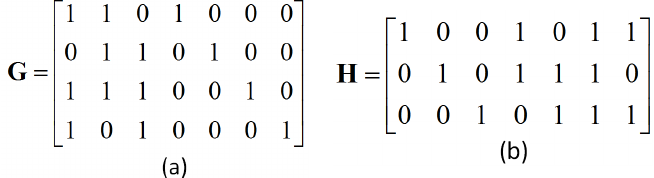
Figure 1. ( a ) Generator matrix G ; and, ( b ) Parity check matrix H of a (7, 4) Hamming code.